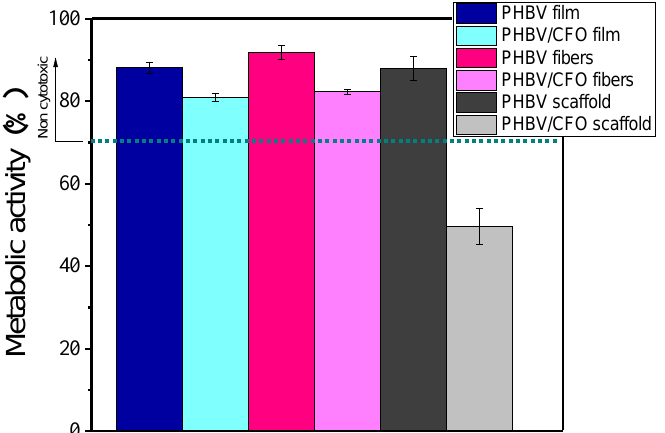
Figure 8. Cytotoxicity assay results of MC3T3-E1 pre-osteoblast cells in contact with the as-prepared extraction media exposed to the different PHBV samples after six weeks of degradation for 72 h (relative metabolic activity was presented as the percentage of the negative control with n = 4 ± Standard Deviation).